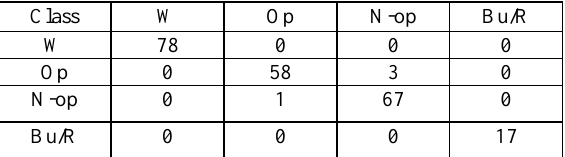
Table 3. Confusion matrix produced in